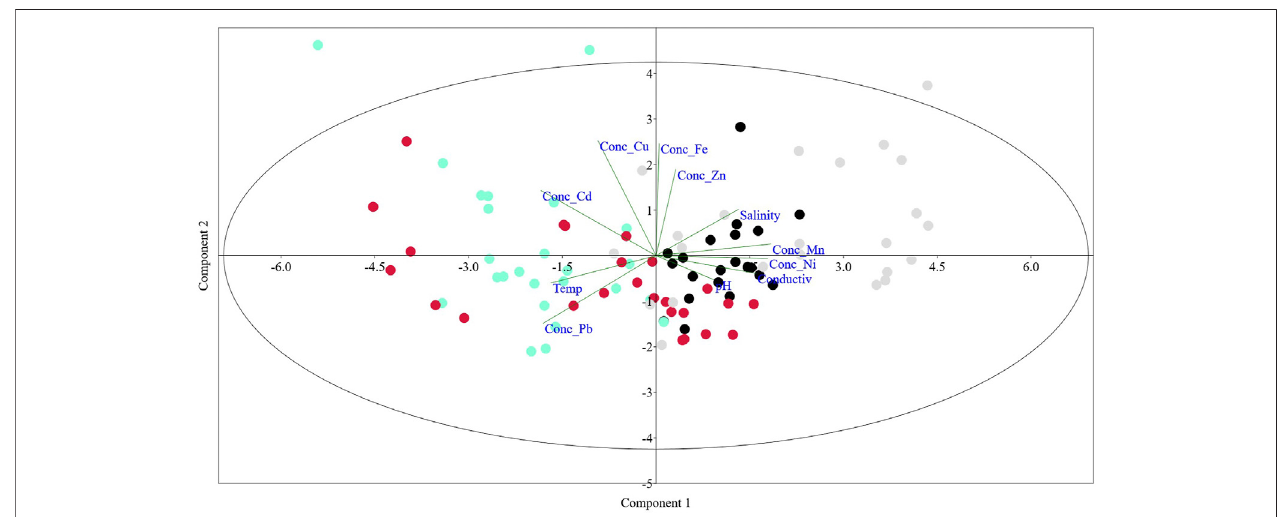
FIGURE 3 | PCA correlation between water physicochemical parameters and trace metals in the edible tissue of C. bellicosus from the NAV complex, Mexico.